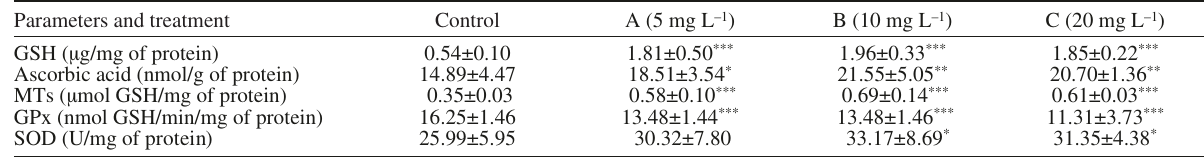
Table 3. – GSH, ascorbic acid and MT levels and GPx and SOD activities in Mactra stultorum gills of control and specimens treated with graded doses of ACR (5, 10 and 20 mg L –1 ) after five days of treatment. Values were expressed as means ±SD. The number of